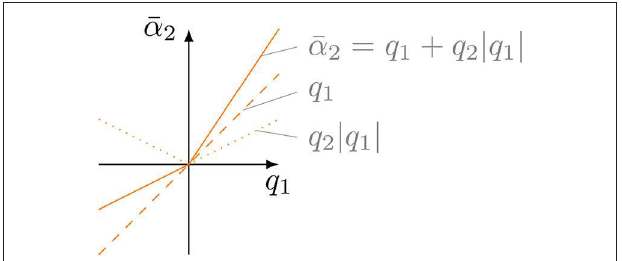
FIGURE 3 | Illustration of how the steering q 2 influences the reference angle of the torso ¯ α 2